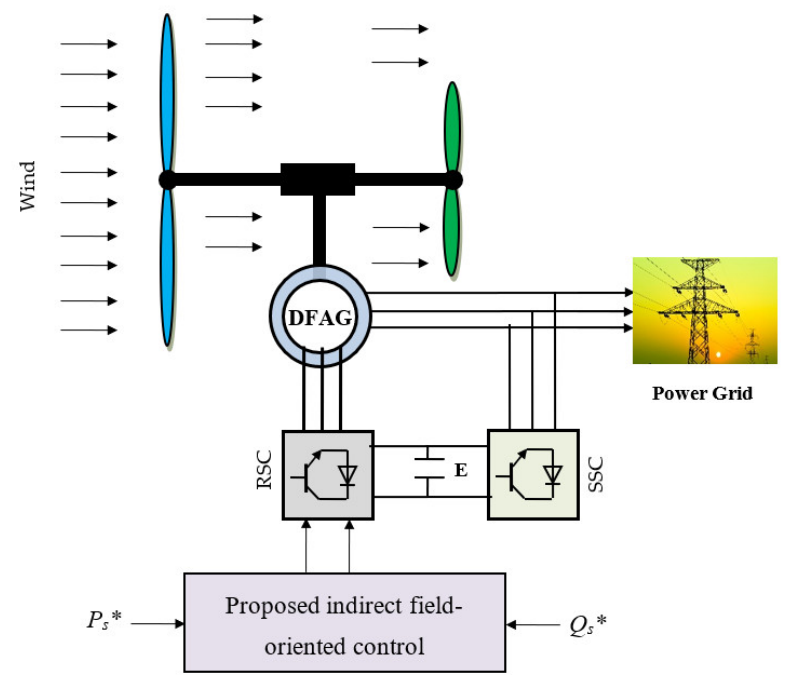
Figure 1. Structure of the MRWT system.